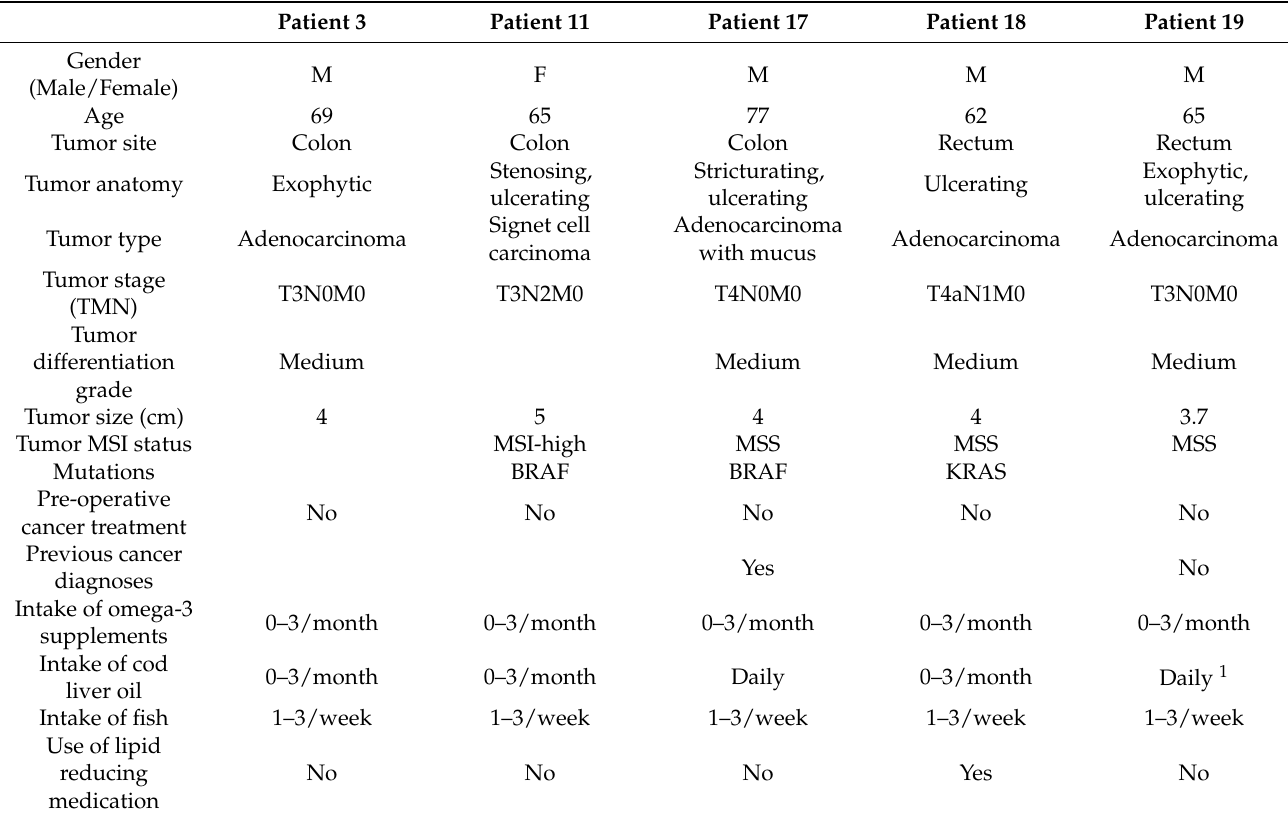
Table 1. Patient and tumor characteristics ( n = 5), and questionnaire